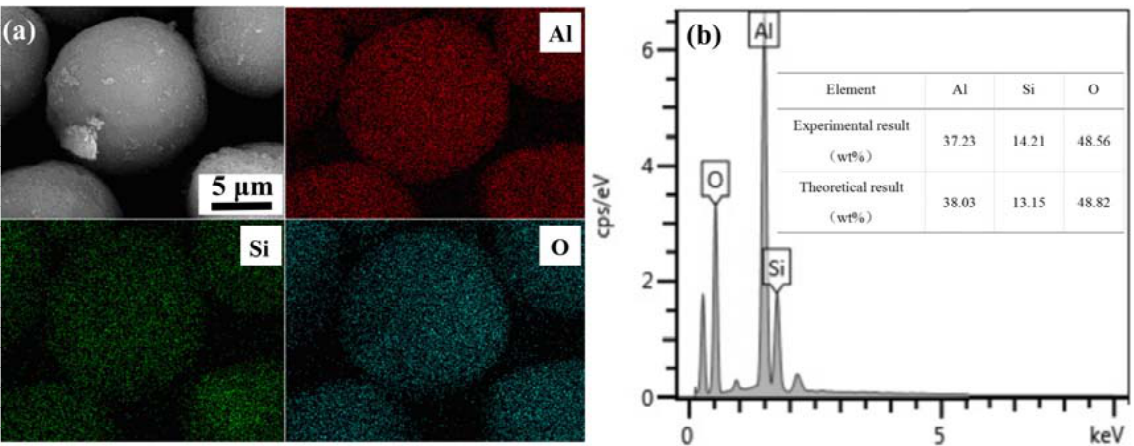
Figure 5. ( a ) SEM image and elemental distribution map of flame spheroidized mullite powders, ( b ) EDS spectrum corresponding to ( a ).